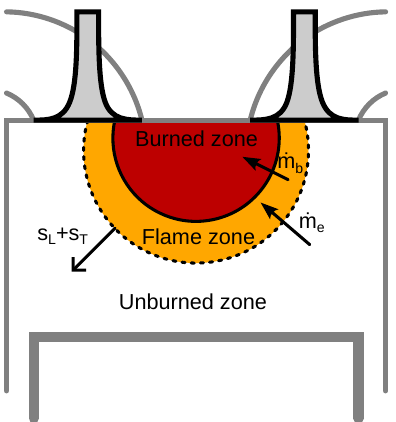
Figure 1. Visualization of the phenomenological combustion model